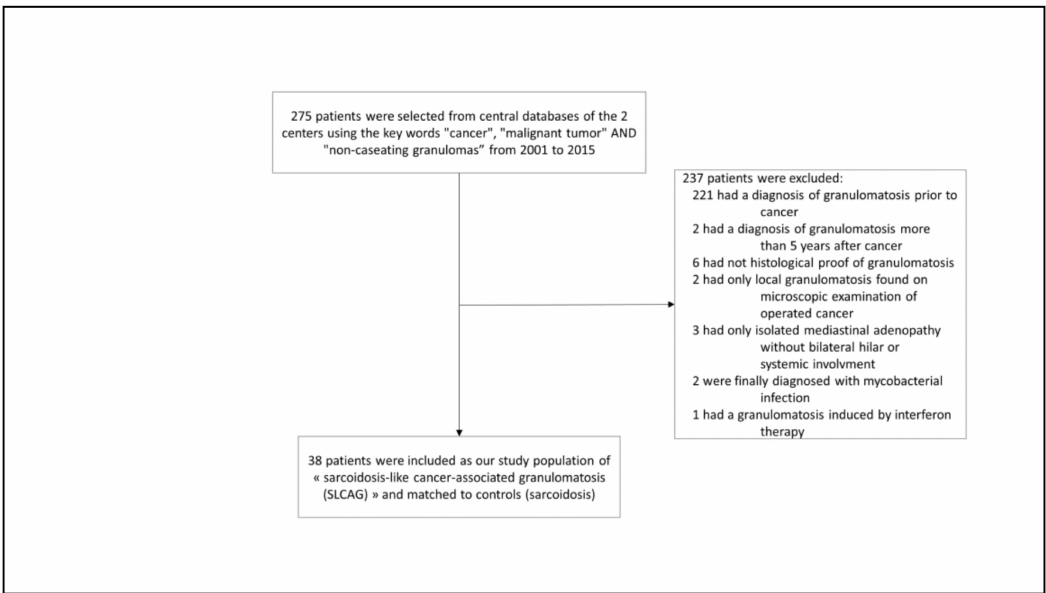
Figure 1. Flowchart of the